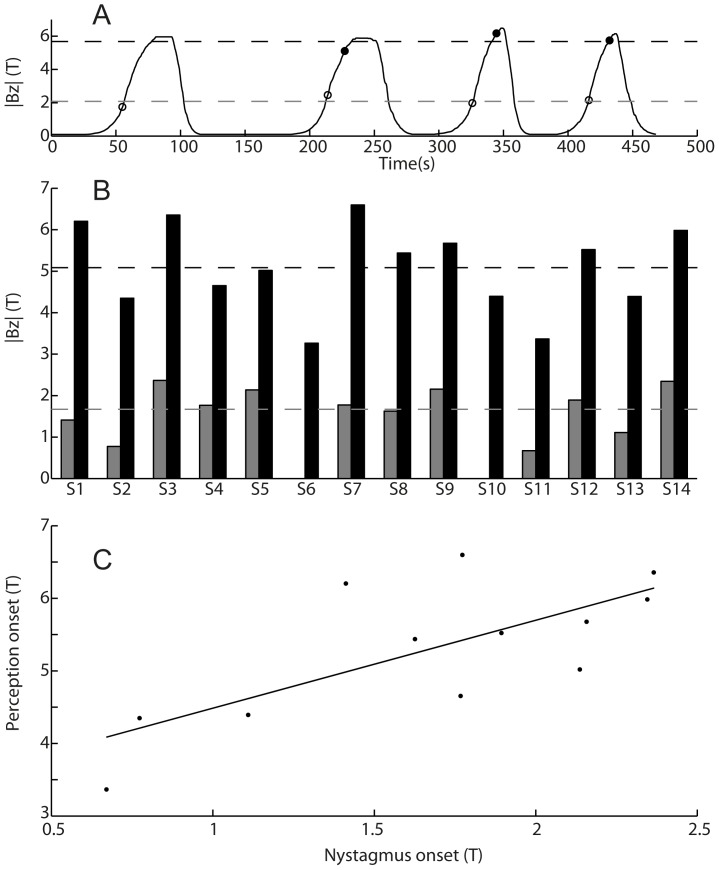
Thresholds of nystagmus and motion perception.
A) Data from single participant showing magnitude of the Z magnetic field (Bz) experienced by the head due to bed being pushed into and removed from the bore 4 times with overlayed open circles indicating points at which nystagmus onset was detected and solid circles indicating points at which onset of non-veridical motion perception was reported for each entry. There is no solid circle for the first entry because this is used as a perceptual scout entry (refer to main text). Horizontal lines represent mean across entries. B) Onset field for nystagmus (grey bars) and perception (black bars) for each participant and group means (horizontal lines). Nystagmus onset not obtained for S6 or S10. C) Perception onset plotted against nystagmus onset with linear regression line. Pearson correlation coefficient = 0.72 (p<.01).